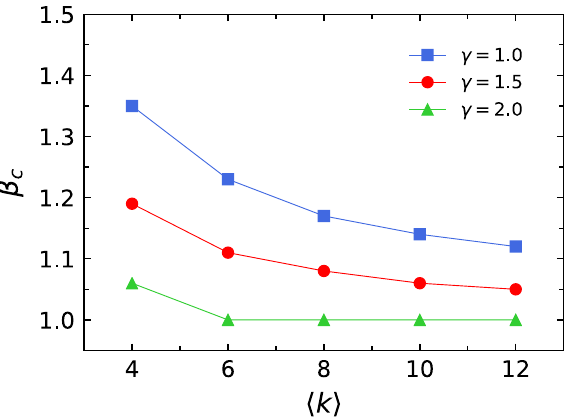
Figure 4. The tolerance parameter β c as a function of the average degree (cid:31) k (cid:30) for γ = 1.0 , γ = 1.5 , and γ = 2.0 . The parameter α in Eq. (1) is set to 1.0 and β c is obtained from the averaged S N vs . β curve for 20 independent runs.